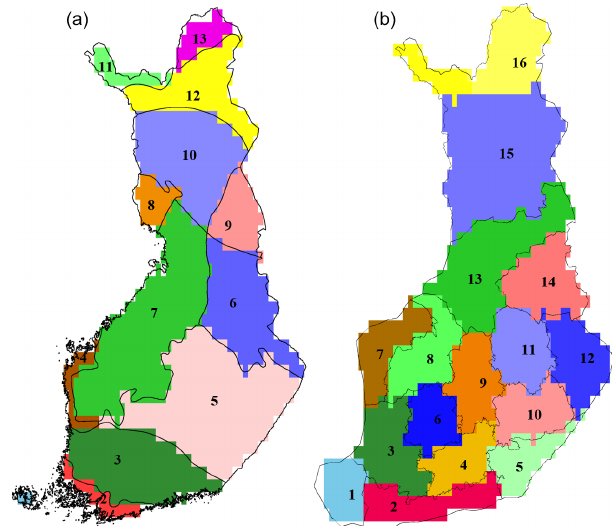
Figure 1. The regions based on the vegetation zones (a) and the re- gions of the forest centres (b) of Finland. The Finnish territory (in- cluding islands) is situated between the latitudes 59.5 and 70.1 ◦ N and the longitudes 19.1 and 31.6 ◦